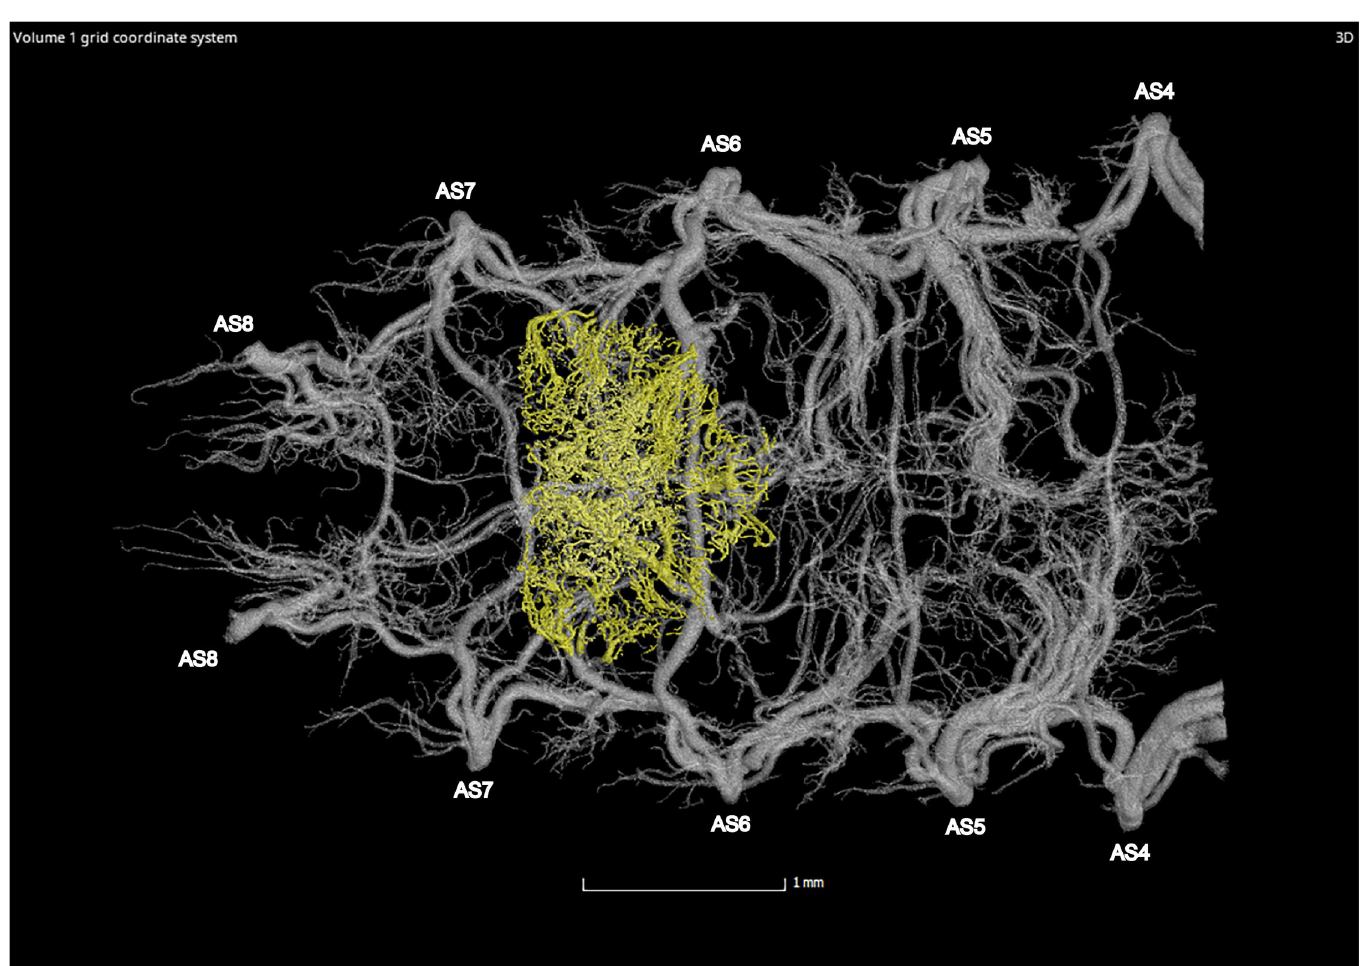
Fig 30. Ventral view of the adult female Photinus pyralis tracheal system with the tracheal brush highlighted in yellow (restricted to abdominal segment VI).